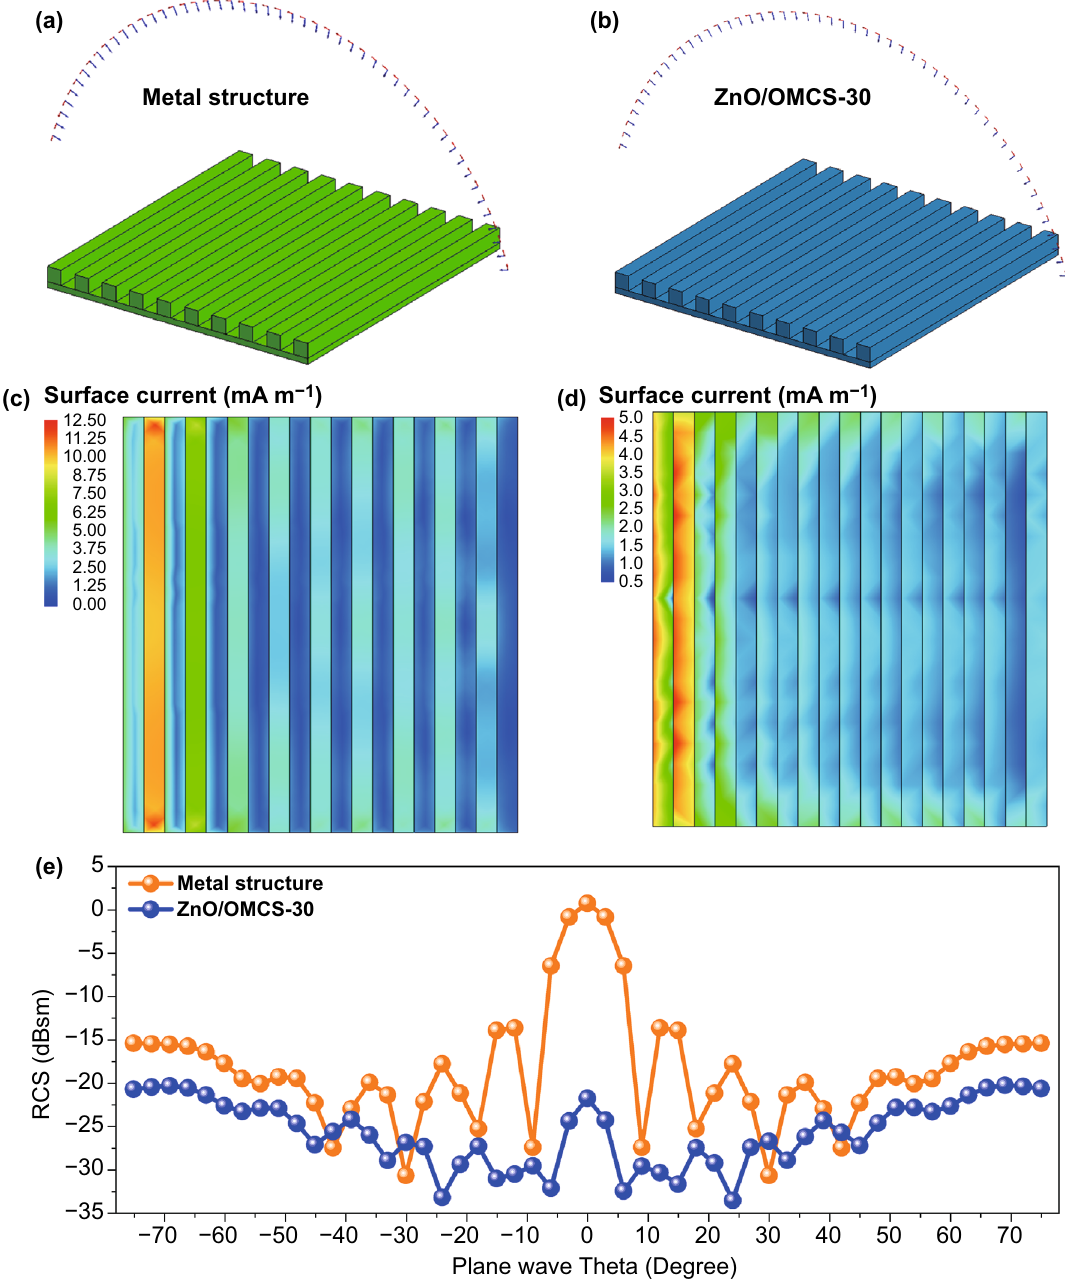
Fig. 11 RCS simulation results of a rectangle metal plate and a rectangle metal plate with ZnO/OMCS. a, b The model of metal plate and metal plate with ZnO/OMCS-30 coatings. c, d Metal plate models and corresponding color maps of simulated current distributions. e RCS values of metal structure and metal structure with ZnO/OMCS